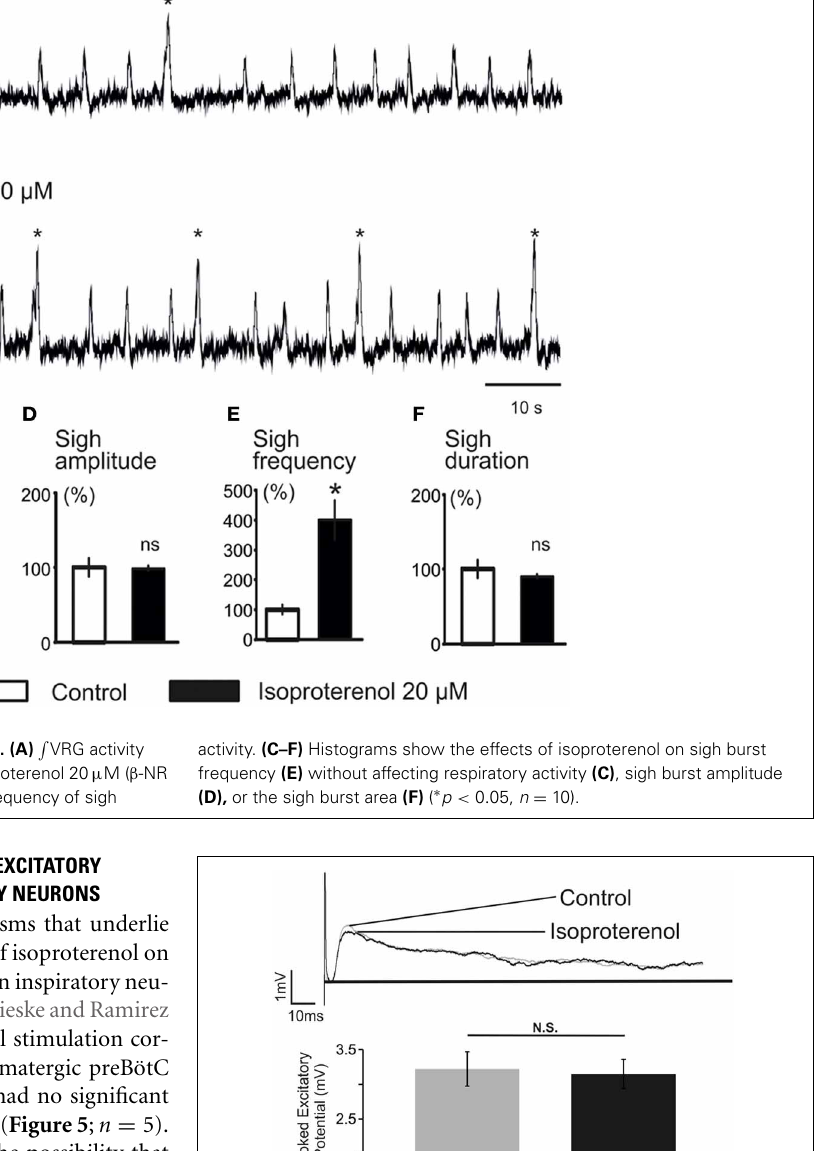
FIGURE 5 | β -NR modulation does not alter the strength of evoked EPSP in preBötC neurons. Top: Representative traces of an electrically evoked EPSP from an preBötC neuron prior to (Control) and during application of isoproterenol (Isoproterenol). Bottom : Summary of the effect of isoproterenol (20–25mM) on the amplitude of the evoked EPSP (N.S. P > 0 . 05; n = 5). (Lieske et al., 2000, Figures 6A , 7A ). Isoproterenol had